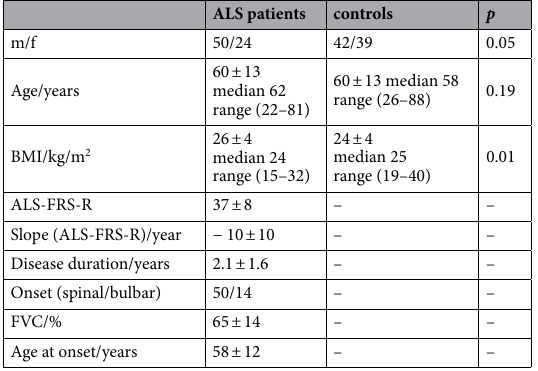
Table 2. Clinical characterization of subject groups. FVC—forced vital